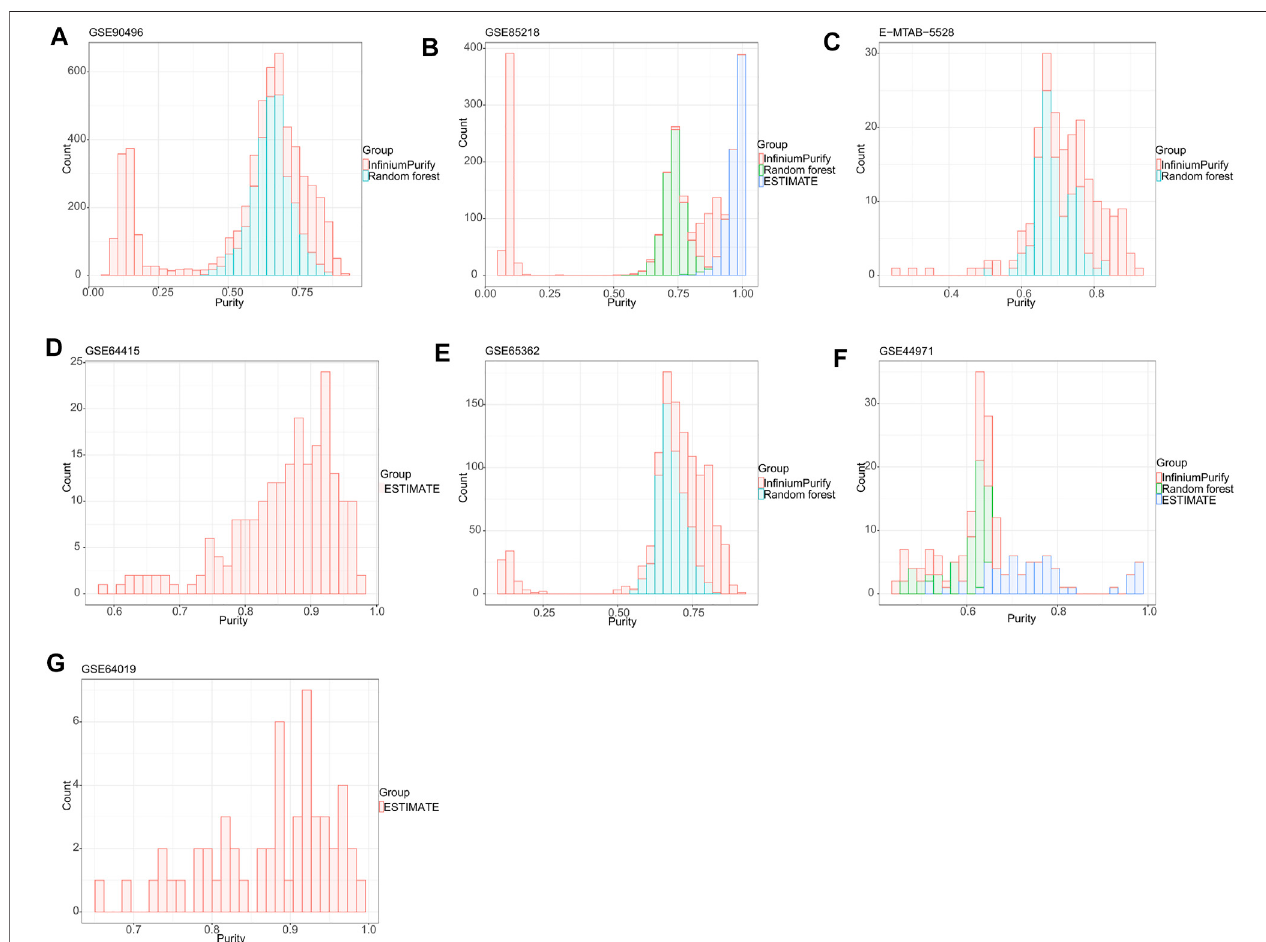
FIGURE 1 | Tumor purity distribution of seven common pediatric CNS tumor datasets based on three methods of tumor purity estimation. (A) Tumor purity distribution of the GSE90496 dataset based on In fi niumPurify and random forest (RF) algorithms; (B) tumor purity distribution of the GSE85218 dataset based on the In fi niumPurify, ESTIMATE, and RF algorithms; (C) tumor purity distribution ofthe E-MTAB-5528 dataset based on the In fi niumPurify and RF algorithms; (D) tumor purity distributionoftheGSE64415datasetbasedontheESTIMATEalgorithm; (E) tumorpuritydistribution oftheGSE65362datasetbasedontheIn fi niumPurifyandRF algorithms; (F) tumor purity distribution of the GSE44971 dataset based on the In fi niumPurify, ESTIMATE, and RF algorithms; (G) tumor purity distribution of the GSE64019 dataset based on the ESTIMATE algorithm.